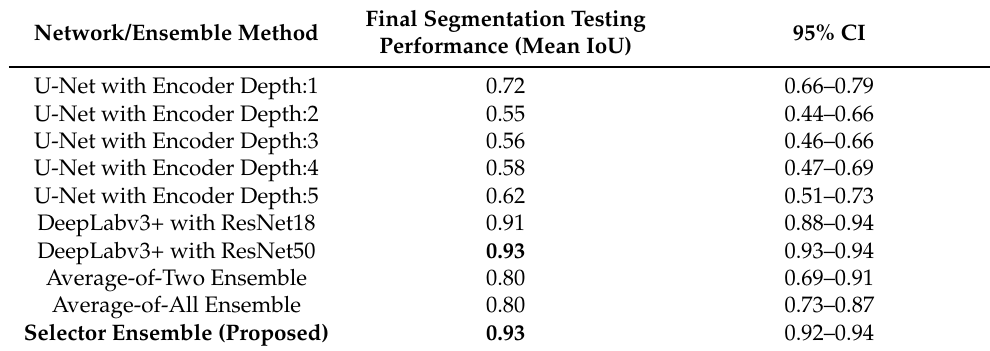
Table 6. Averaged mean IoU values of the final lung segmentations obtained during testing with the ‘selected’ cases out of 138 CRs from the MC dataset. The highest performance value is marked in bold.